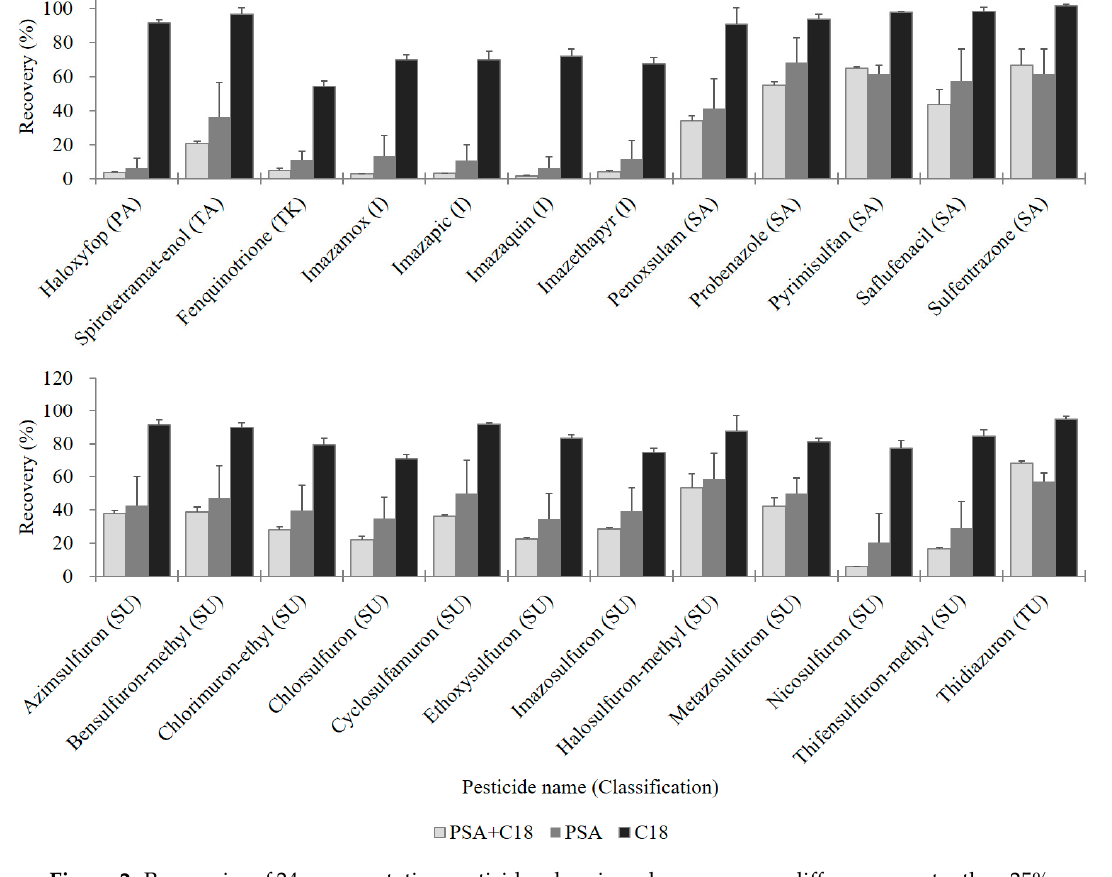
Figure 2. Recoveries of 24 representative pesticides showing a large recovery difference greater than 25% depending on dSPE sorbent combination (PSA + C18, PSA, and C18). PA, propionic acid; TA, tetramic acid; TK, triketone; I, imidazolinone; SA, sulfonamide; SU, sulfonylurea; and TU, thiadiazolylurea. The error bars are the standard deviations of the recovery rates ( n = 3).